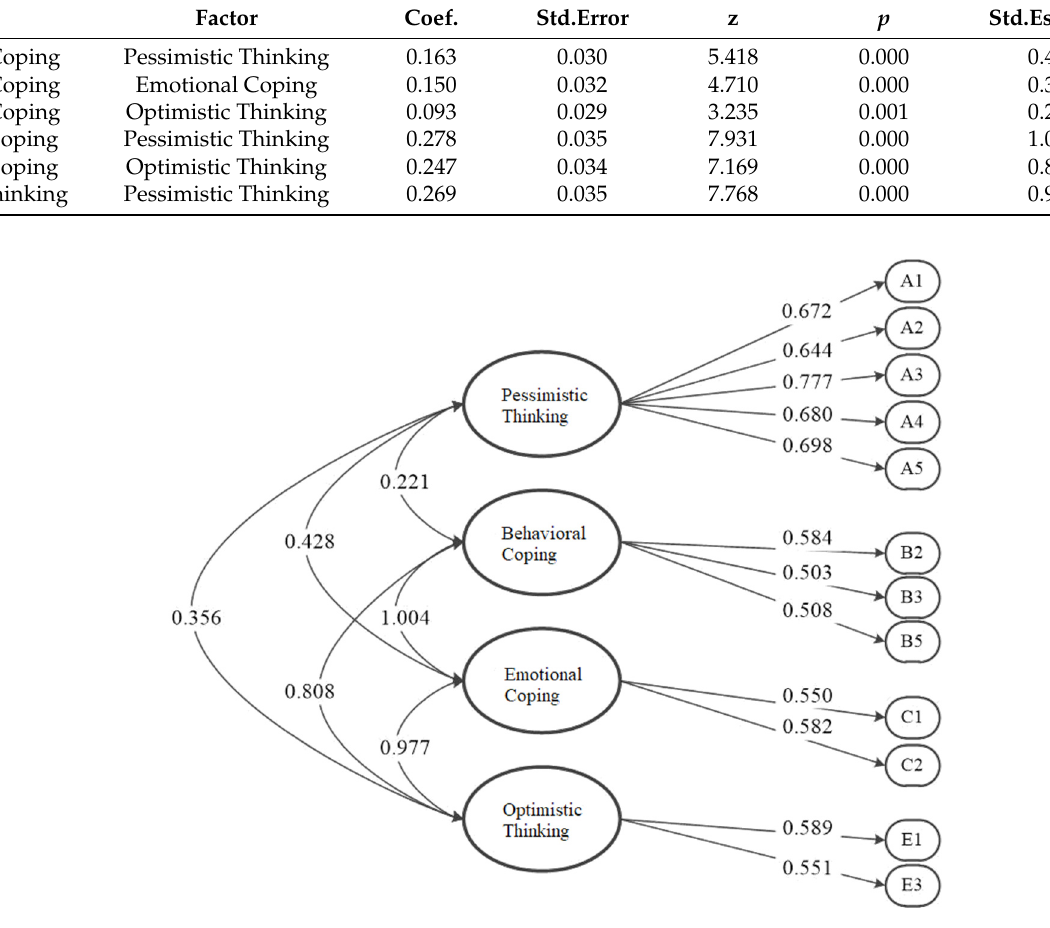
Figure 2. CFA Model Diagram.